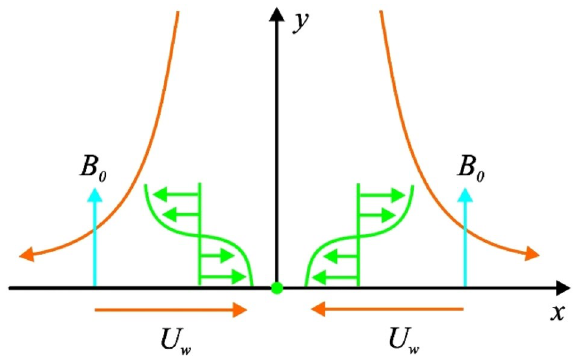
Figure 1. Schematic flow